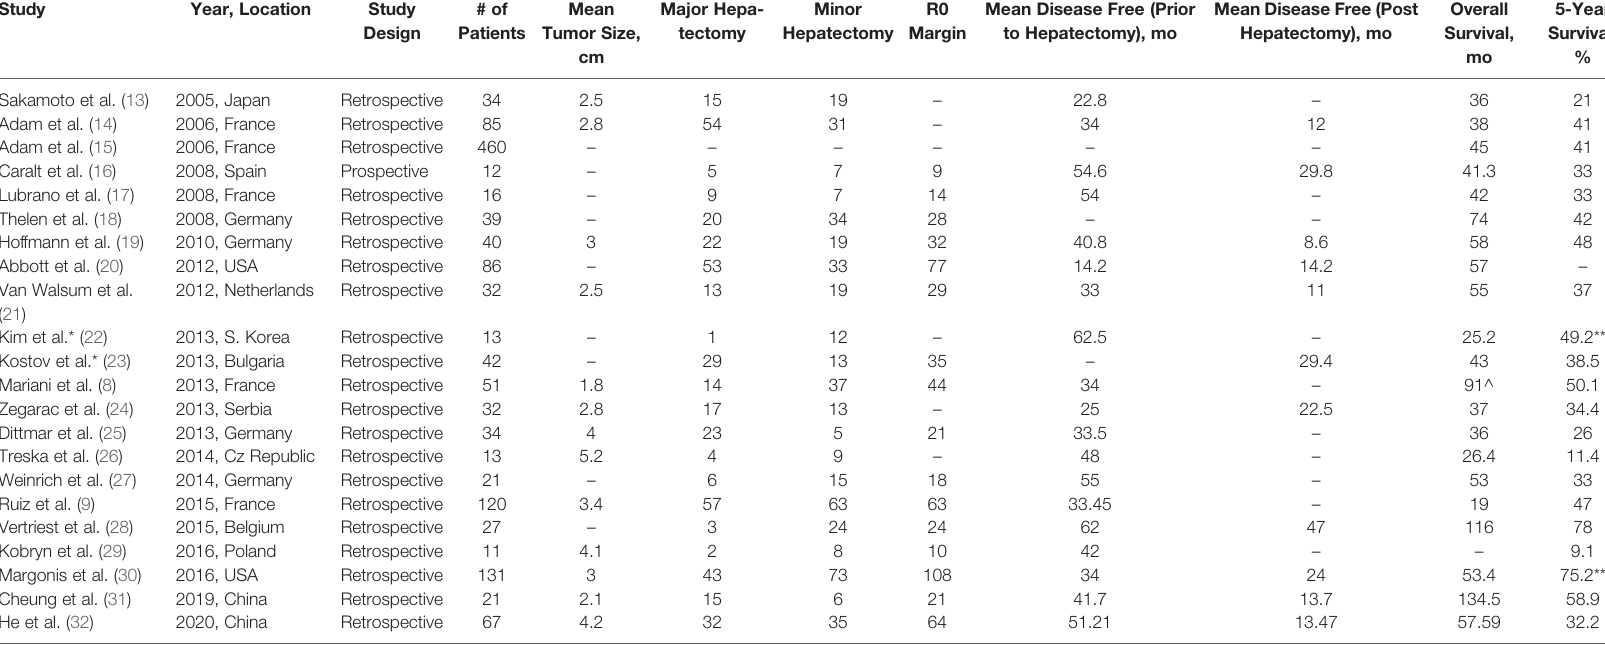
TABLE 2 | Hepatic Resection for